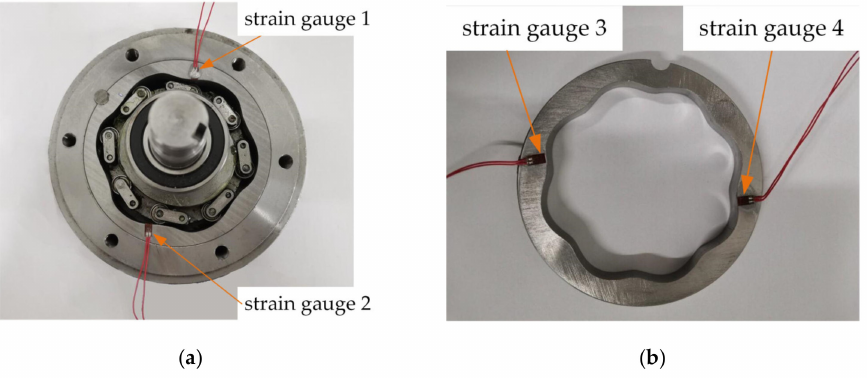
Figure 12. Strain gauges for test: ( a ) Ring gear pasted strain gauges; ( b ) Temperature compensated strain gauges.